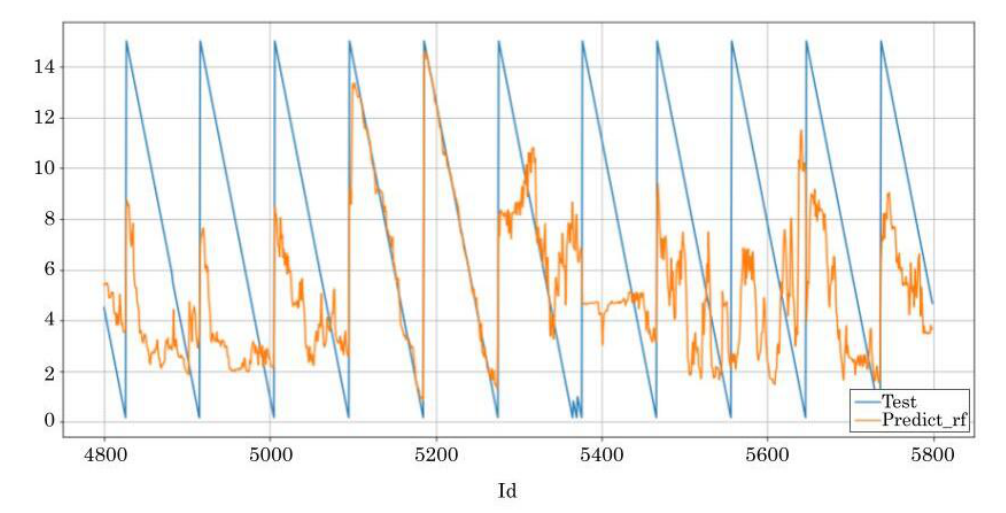
Figure 13. Difference between real and predicted TTF values for WT